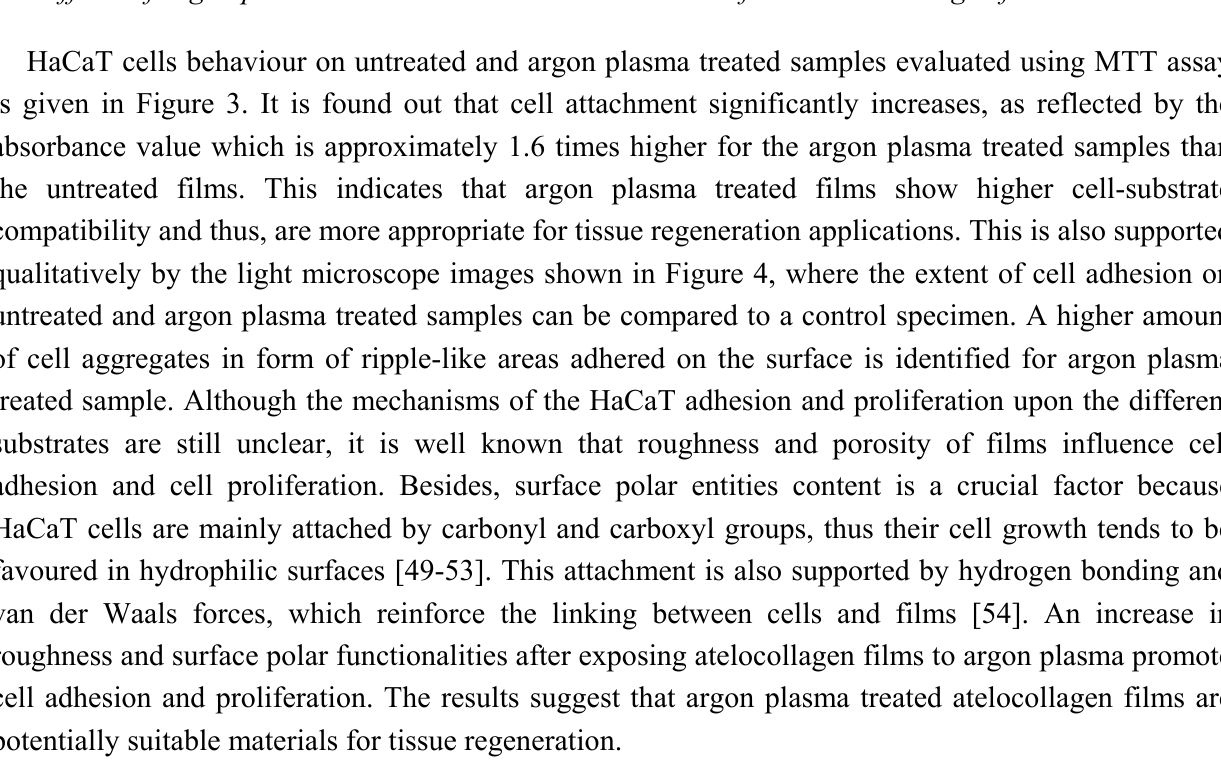
Figure 3. Comparison of HaCaT cells growth upon untreated and argon plasma-treated films, measured by MTT cell proliferation assay at 570